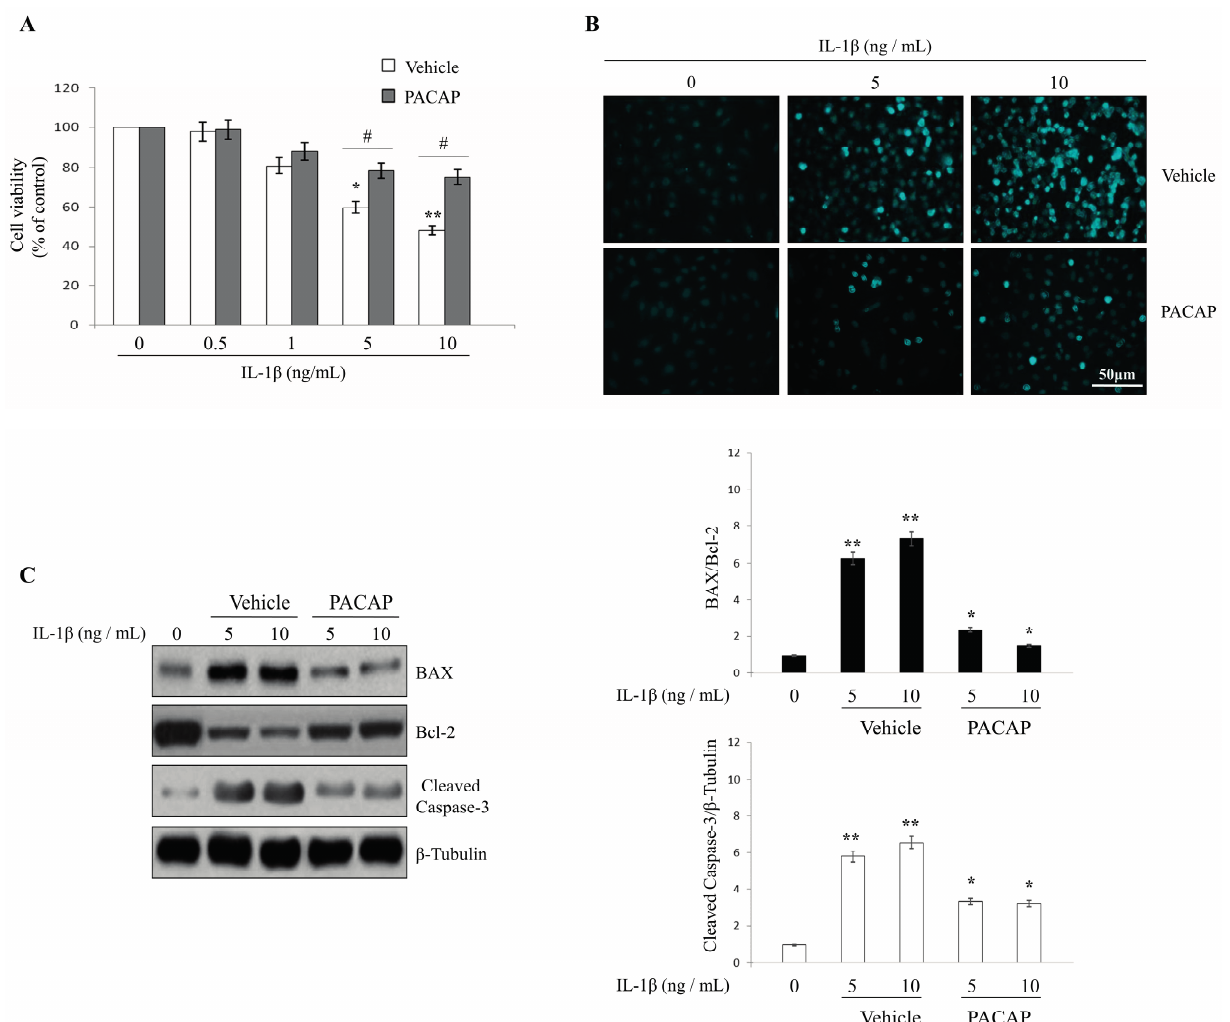
Figure 5. Effects of PACAP on IL-1 β induced chondrocyte apoptosis. Chondrocytes were exposed to either vehicle or interleukin 1- β (IL-1 β ) for 24h at indicated concentrations and cell viability ( A ), DNA damage ( B ) as well as the expression of apoptotic-related proteins (Bcl-2, BAX and Cleaved Caspase-3, respectively) were analyzed as detailed in “Materials and Methods”; ( A ) MTT analyses. Values are expressed as mean optical densities (ODs) ± SEM, obtained from three separate batches of cells, each run in duplicate; ( * p < 0.05 or ** p < 0.01 vs. untreated cells; # p < 0.05 vs. vehicle); ( B ) Hoechst 33258 nuclear staining. Cells were stained with the fluorescent nuclear dye Hoechst 33258 and viewed at ×40 magnification; Scale bar = 50 μ m. At least three randomly selected fields from five independent cultures on cover slips were assessed; ( C ) Western blot analyses of Bcl-2, BAX and Cleaved Caspase-3. Bands were quantified using ImageQuantTL software. BAX/Bcl-2 ratio and Cleaved Caspase-3 normalized values were plotted in the bar graph shown on the right of the representative blots. Quantification of band intensities was performed using the freely available Image J software. Results are reported as average values ± SEM, ( * p < 0.05 or ** p < 0.01 vs. untreated cells). Each experiment was performed at least three times using three different batches of cells ( n =